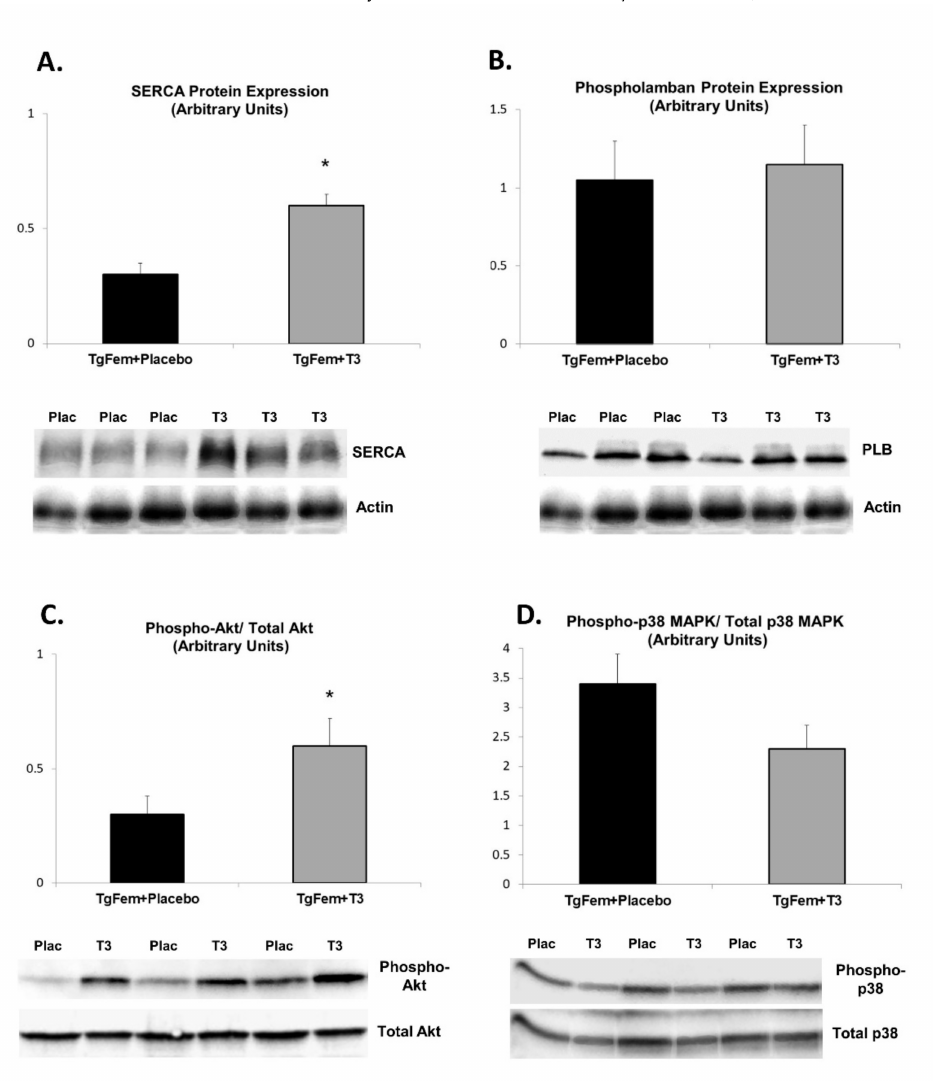
Figure 3. Reversal of molecular phenotype of cardiac dysfunction in Tg197 female mice upon treat- ment with T3. Densitometric assessment in arbitrary units and representative images of SERCA2a protein expression ( A ), PLB protein expression ( B ), phosphorylated and total Akt ( C ) and phospho- rylated and total p38 MAPK ( D ) in left ventricle of TgFem + Placebo versus TgFem + T3 female mice. * p < 0.05. (SERCA: Sarcoplasmic Reticulum–Calcium ATPase, PLB: Phospholamban, LV: left